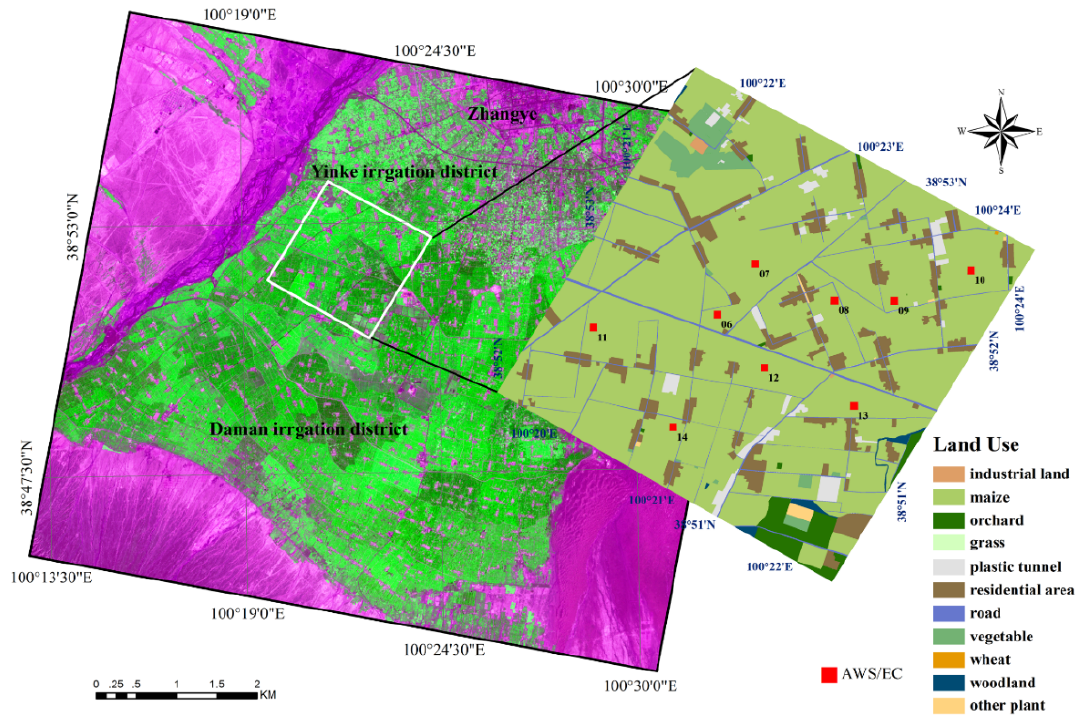
Figure 1. Land cover and the meteorological instrument locations in the study area.